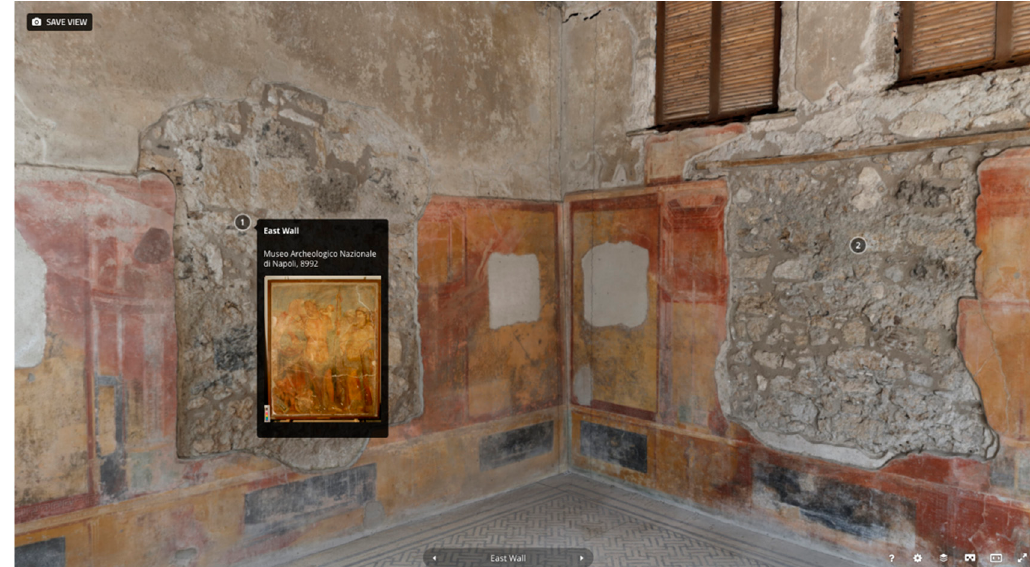
Figure 11. Room 16, east wall. Screenshot showing the interactive 3D model in SketchFab, with the embedded wall paintings from the Museo Archeologico Nazionale di Napoli . Model Courtesy: Kelly McClinton. Image Courtesy: photos for the 3D model on concession of the Ministero dei Beni e delle Attività Culturali e del Turismo, Parco Archeologico di Pompei (used by permission).